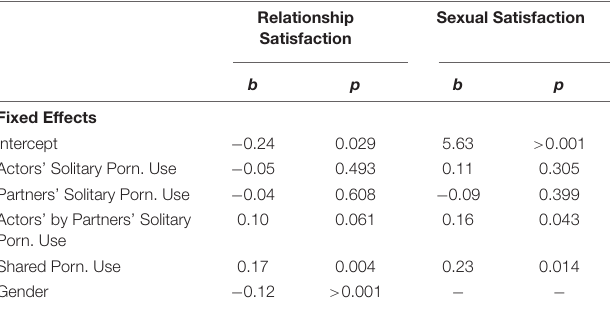
TABLE 2 | Linear mixed models predicting relationship and sexual satisfaction for Study 1 ( N = 200